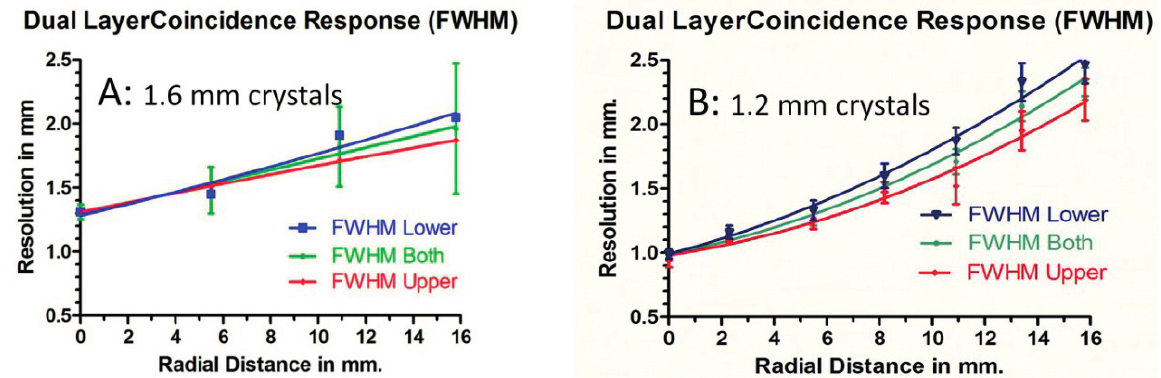
Figure 12. The coincidence response function as it changes with radial distance for ( A ): a block with 49 lower, and 36 upper layer crystals 1.6 × 1.6 mm 2 ; ( B ): 64 lower and 49 upper layer crystals 1.2 × 1.2 mm 2 .